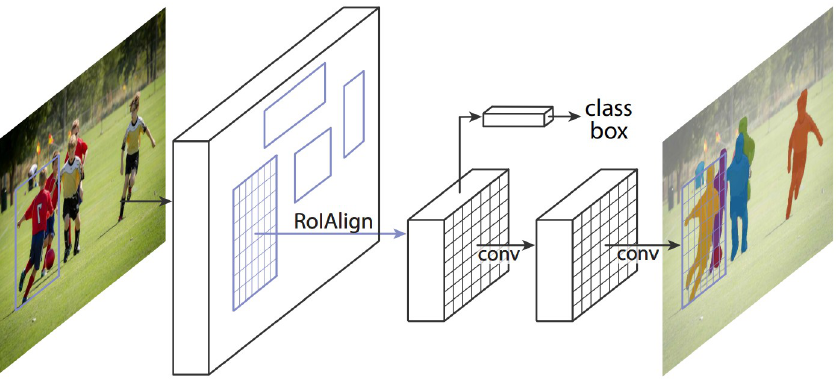
Figure 8. Mask R-CNN framework, for instance, segmentation. (Reprinted from ref. [8]).